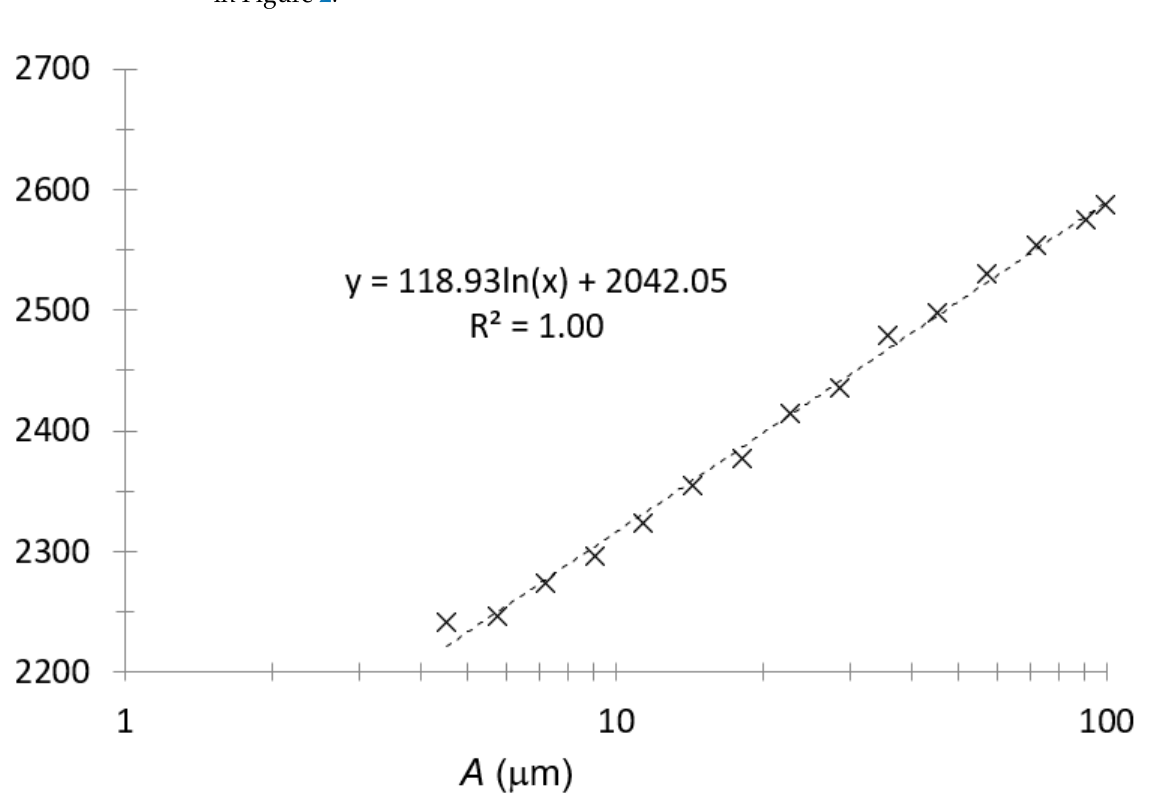
Figure 3. Flexural modulus – strain rate plot of amplitude sweep for PA66.